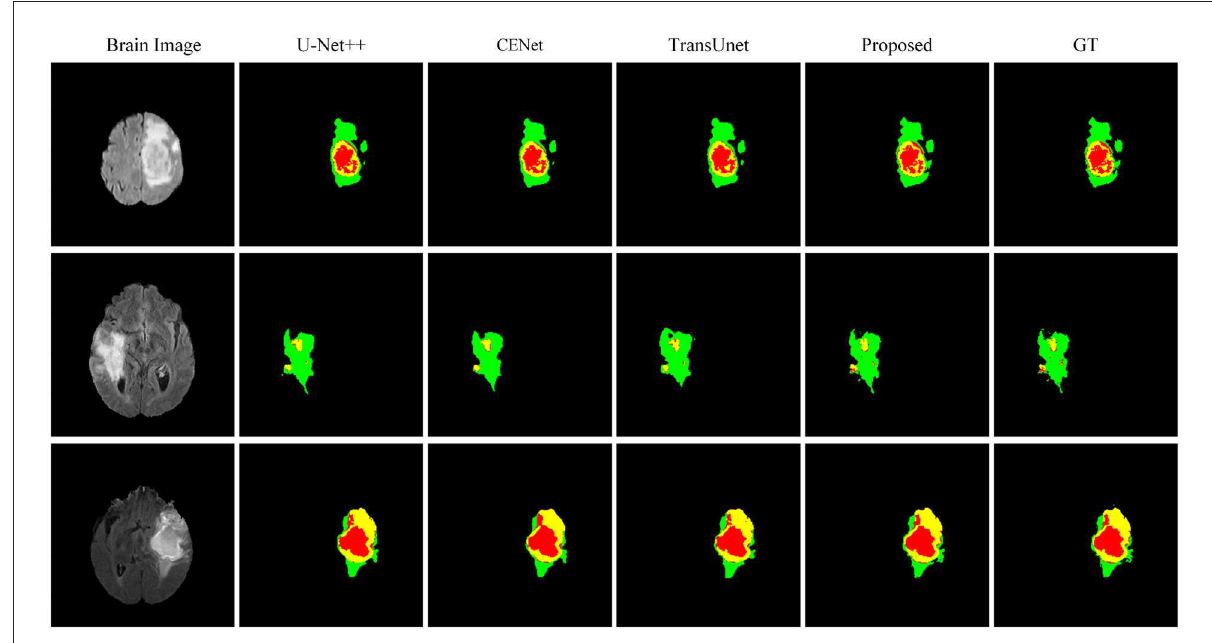
FIGURE4 Comparison of the proposed method and other state-of-the-art methods on BraTS2018.